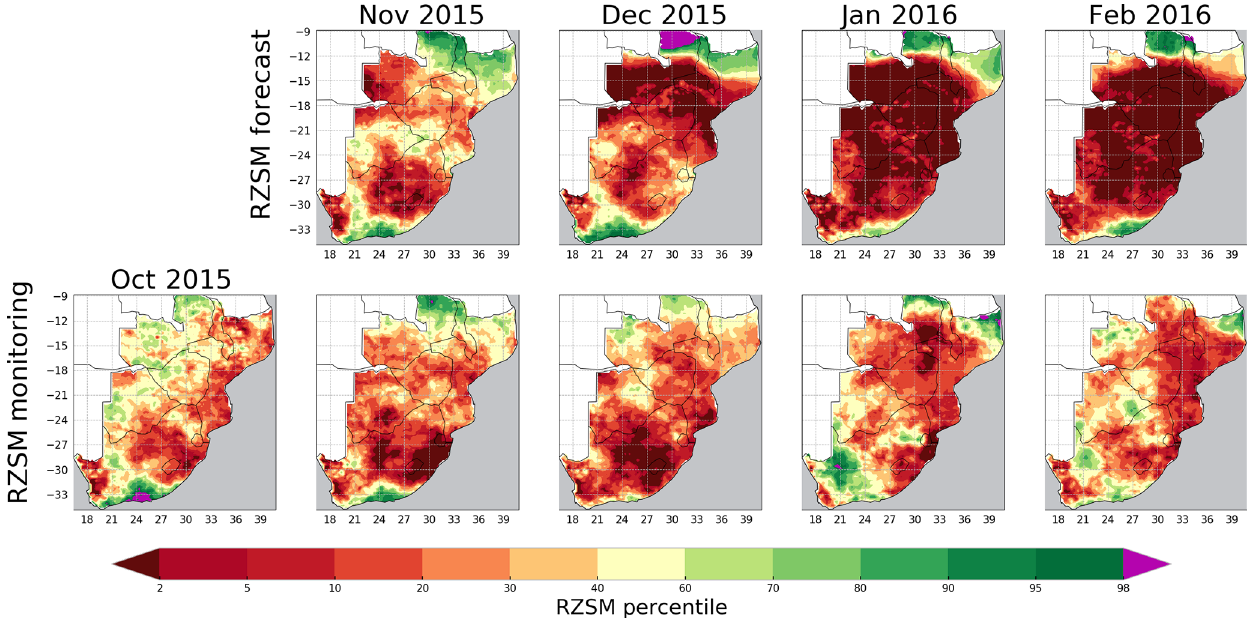
Figure 4. Forecast (top panels) and monitoring of root-zone soil moisture (RZSM) percentiles for the months of November 2015 through February 2016. October 2015 conditions reflect the state of RZSM during the month preceding the forecast initialization on 1 November 2015. The RZSM monitoring product for a given month is available during the early part of the following month. The historical climatology (1982– 2010) was used to calculate percentile.